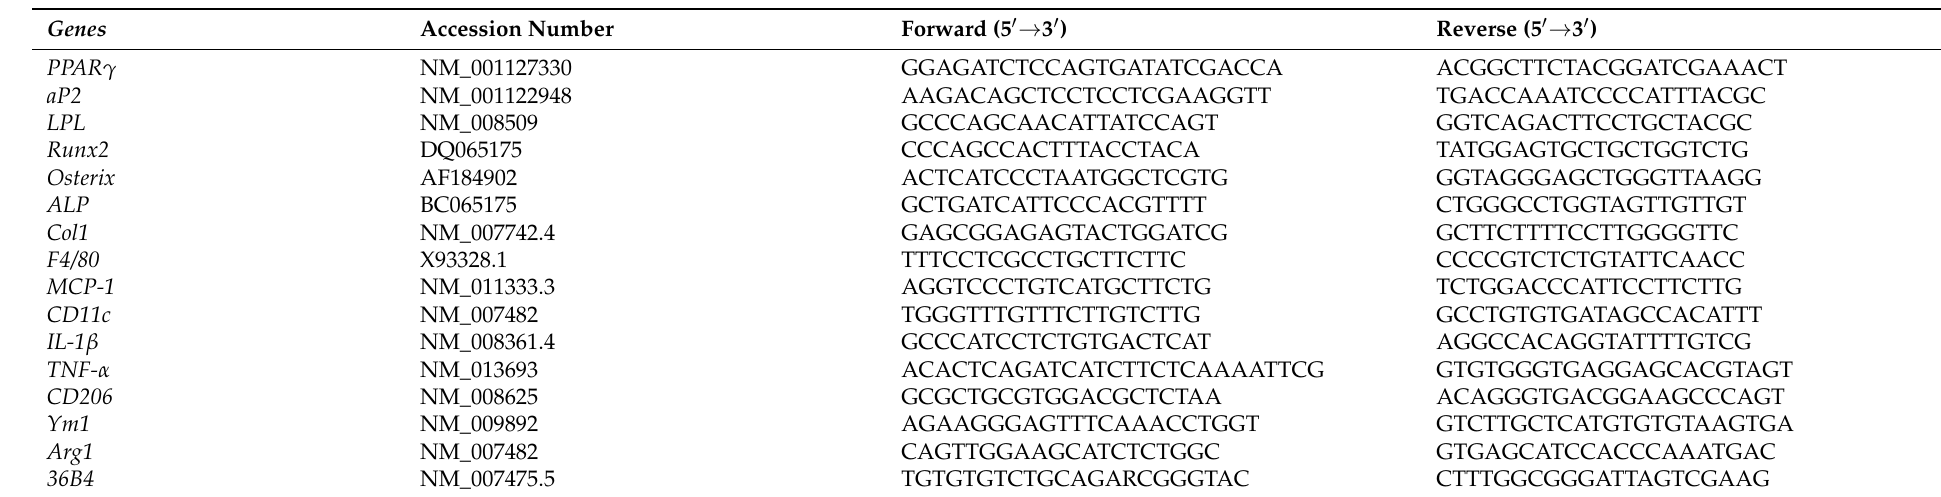
Table 3. Primers for real-time